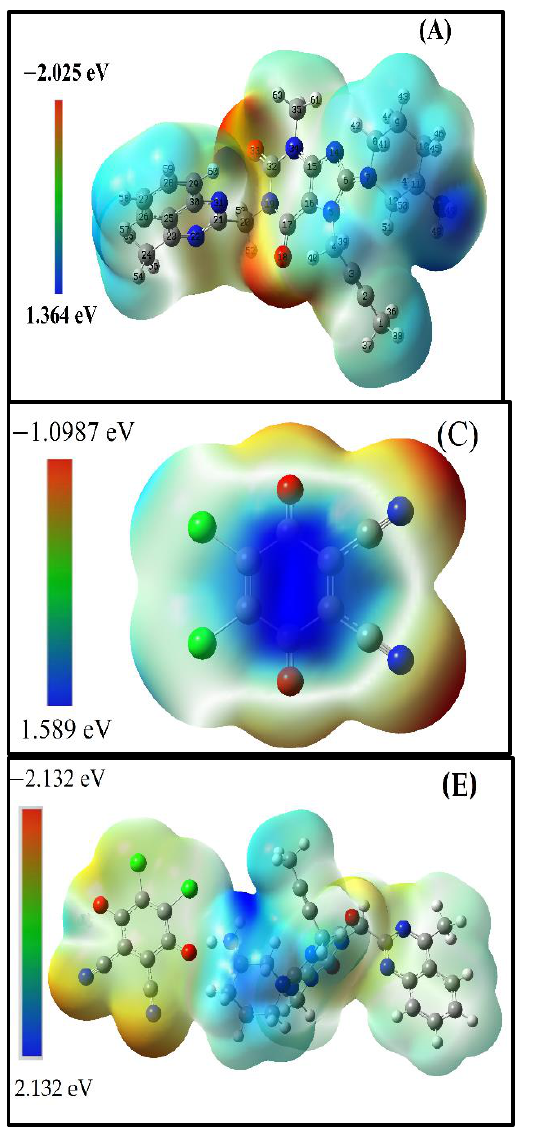
Figure 9. Molecular electrostatic potential (MESP) maps of ( A ) LGN, ( B ) LGN + 1, ( C ) DDQ, ( D ) CHA, ( E ) LGN···DDQ and ( F ) LGN···CHA. MESP maps of this structure have a blue region (positive) found in the ( π -hole) around C17, C16, C15, N34, N14, C6, N5, and N7, as well as σ -hole localized around the